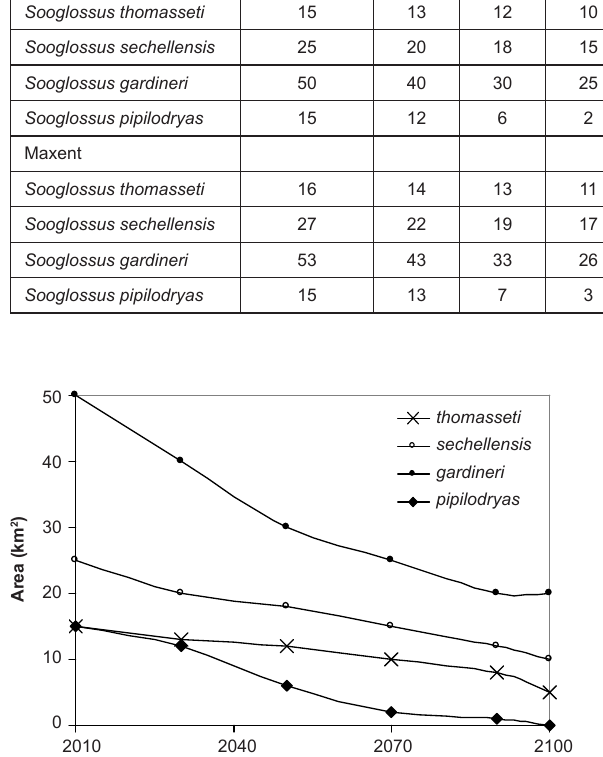
Figure 5. Projected changes in Sooglossidae distribution (in km 2 ) as a result of climate